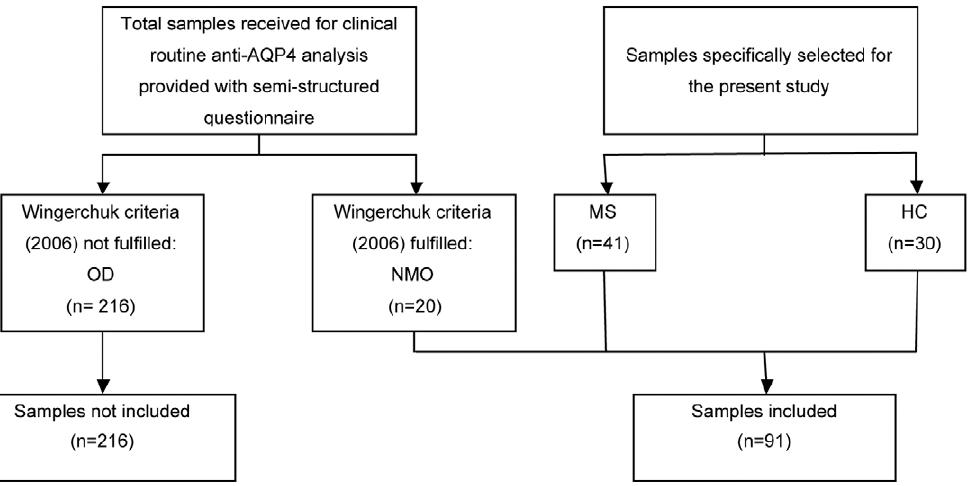
Figure 1. Recruitment of NMO patients, MS patients and HC. OD: Other diseases, NMO: neuromyelitis optica, MS: multiple sclerosis, HC: healthy